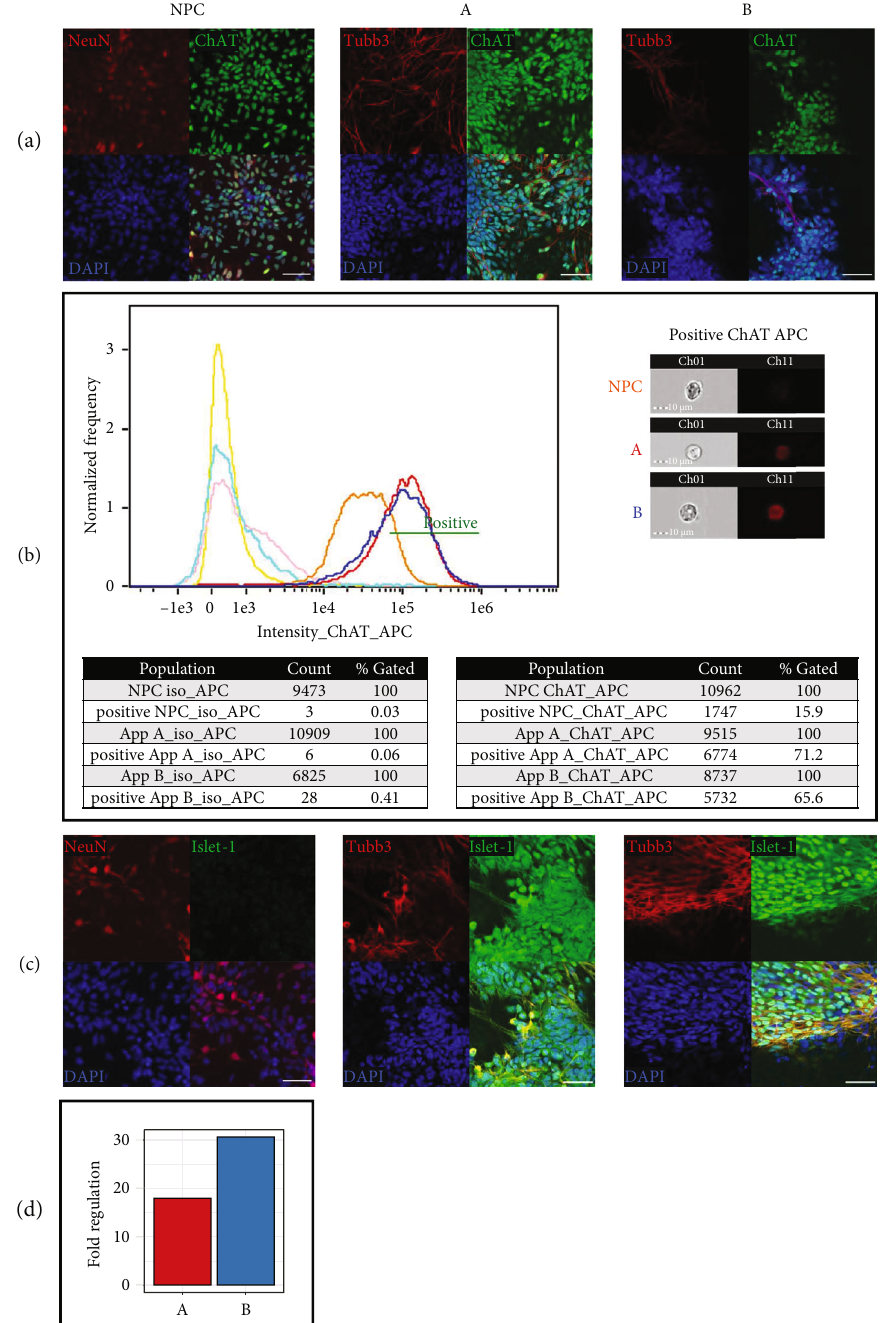
Figure 6: Late motoneuronal di ff erentiation marker ChAT and Islet-1. (a) Immuno fl uorescent images show nuclear ChAT expression (green) in NPC and neurons of approach A and B. Cell nuclei were counterstained with DAPI (blue). Scale bars, 50 μ m. (b) In fl ow cytometry, cells of approach A and B revealed a higher ChAT-APC staining intensity compared to NPC. Representative images acquired during the fl ow stream highlight the di ff erence in ChAT expression ( n = three randomly selected images per group from three independent experiments). Scale bars, 10 μ m. (c) Islet-1 (green) is selectively expressed in neurons of approach A and B, as shown in representative immuno fl uorescent images. Cell nuclei were counterstained with DAPI (blue). Scale bar, 50 μ m. (d) Approach A and B show increased Islet-1 gene expression, detected by qRT-PCR ( n = three independent experiments). See Figure 3 for all